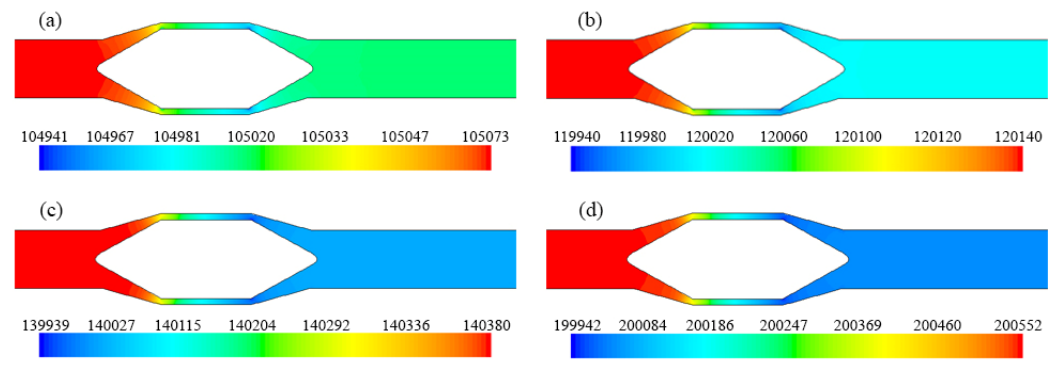
Figure 12. Absolute pressure (Pa) profile of the mixture: ( a ) case #1.1; ( b ) case #2.3; ( c ) case #4.4; ( d ) case #5.5.